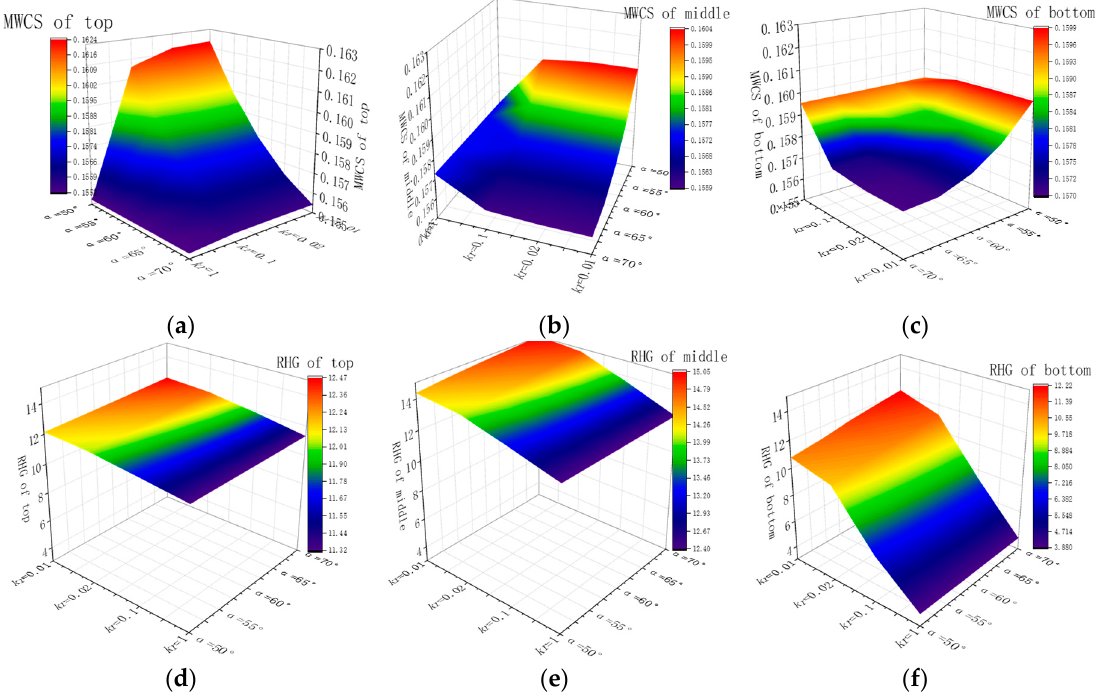
Figure 12. Variations in the MWCS and RHG with different k r and α .: ( a ) MWCS of top of the slope; ( b ) MWCS of the middle of the slope; ( c ) MWCS of the bottom of the slope; ( d ) RHG of top of the slope; ( e ) RHG of middle of the slope; ( f ) RHG of the bottom of the slope.